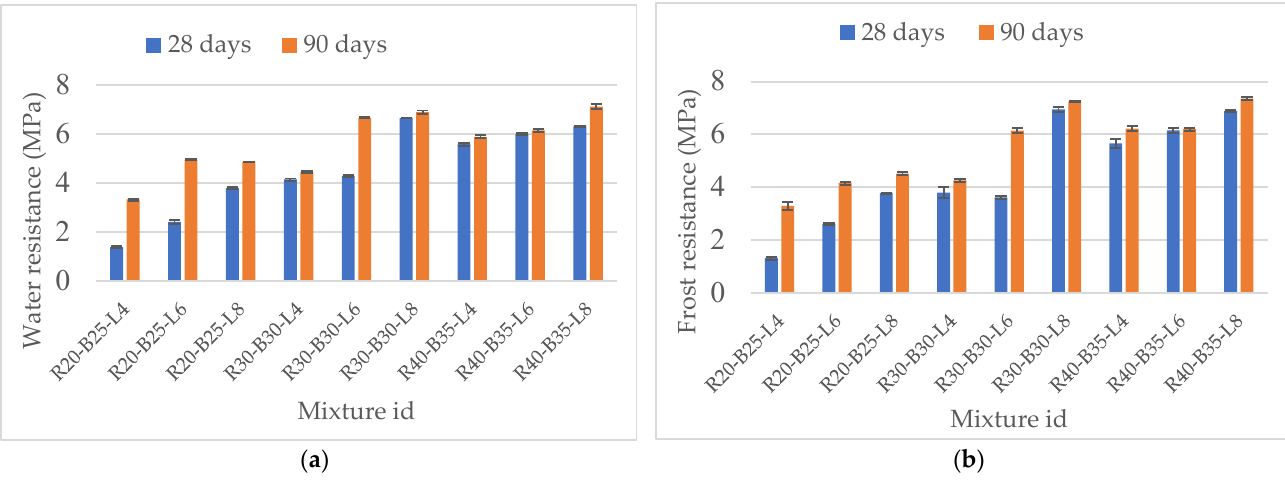
Figure 8. Results: ( a ) water resistance and ( b ) frost resistance.